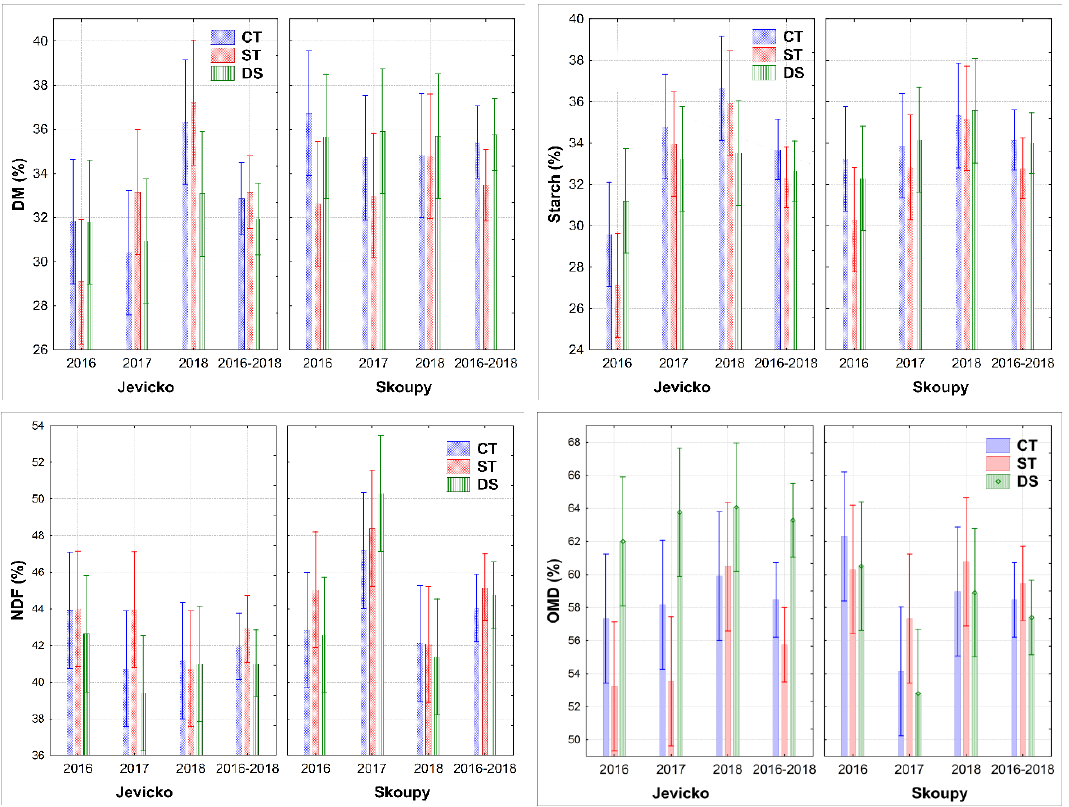
Figure 3. The forage quality parameters of maize in period 2016–2018. Note: DM—Dry Matter, NDF—Neutral Detergent Fibre, OMD—Organic Matter Digestibility.